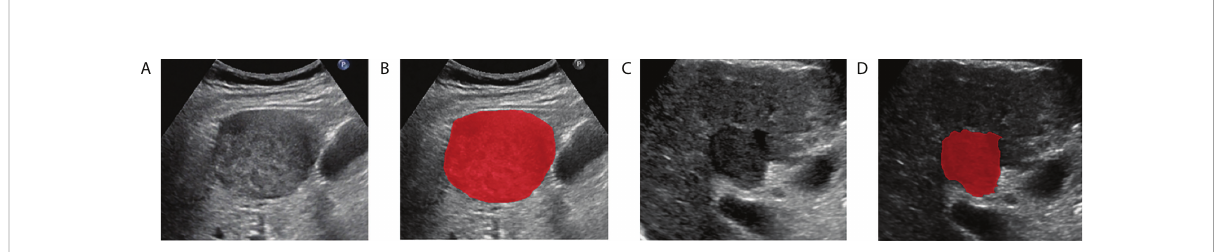
FIGURE 3 Examples of delineating regions of interest (ROI) on a grayscale ultrasound image. (A, B) are the CK19-positive HCC patient, (C, D) are the CK19-negative HCC